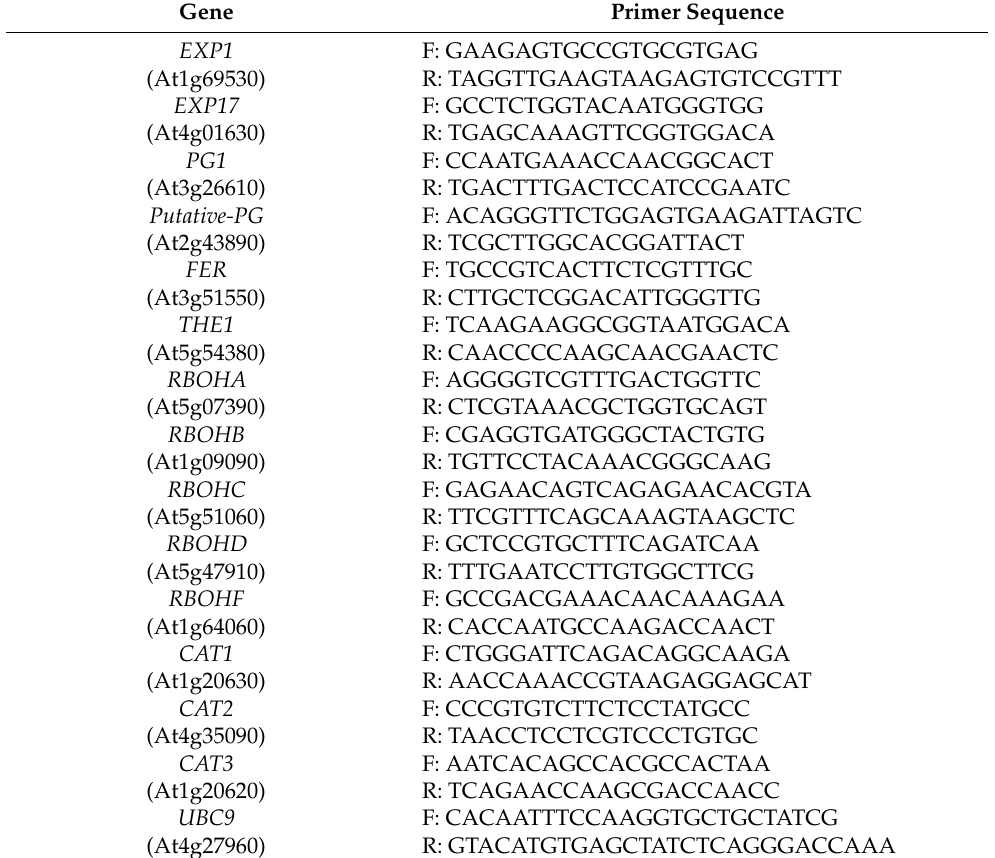
Table 1. The primer sequences of